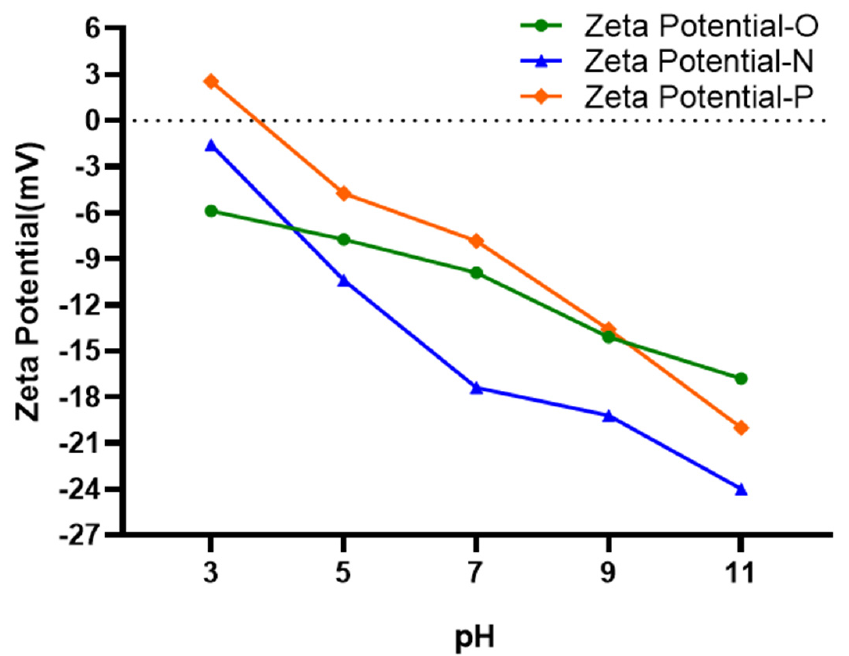
Figure 8. Zeta potentials of plant ash as a function of pH.